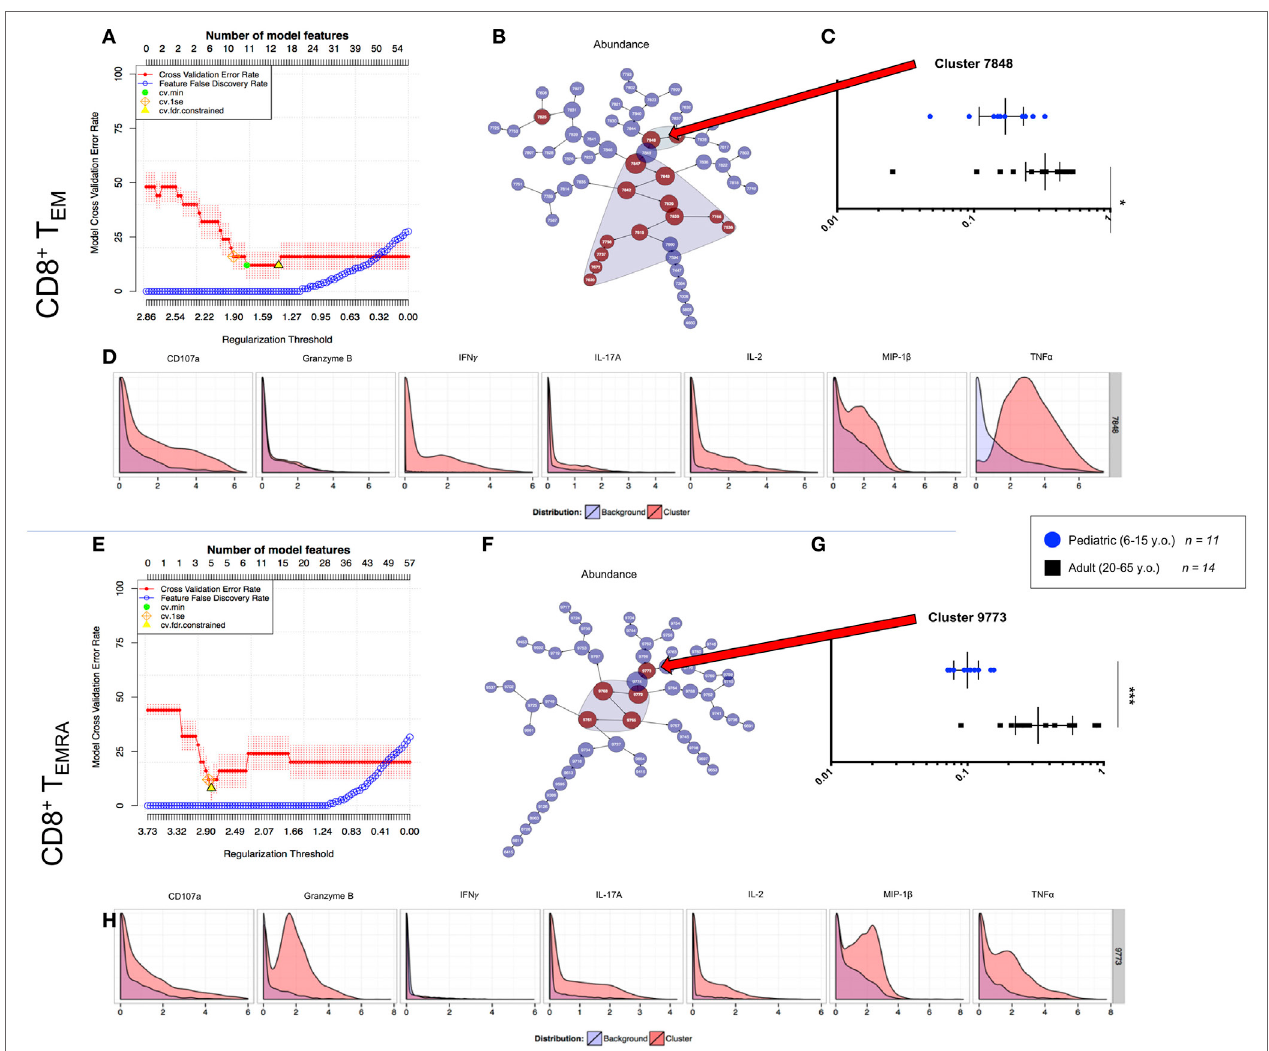
FigUre 6 | CITRUS analyses of peripheral multifunctional CD8 + T cell memory subsets. (a,e) Model error rate graphs showing false discovery rate constrained data points (yellow triangle—from which subsequent data are analyzed). This model analyzes the highest number of features (upper x axis) and the lowest cross validation error rate (red line) to determine the point at which the false discovery rate (blue line) increases. (B,F) Feature plots showing clusters of which significant differences (model features) between populations [i.e., 6–15-year-old pediatric ( n = 11) and 20–64-year-old adult ( n = 14) volunteers] are shaded. The clusters are nested from the center cluster, so the largest, most significant multifunctional clusters were chosen for analysis. The differences between the two populations within each of the chosen clusters for memory subsets (c) T EM , and (g) T EMRA are shown, with each point in the box plot representing a separate participant. Values are a decimal equivalent of a percentage between 0 and 1, with median and interquartile ranges. Plot statistics were analyzed by Mann–Whitney test (* p < 0.05; *** p < 0.001). Chosen cluster features for each memory subset are shown (D,h) with the red histogram representing the effector expression within the chosen cluster and the blue histogram representing the average effector expression across the sampled